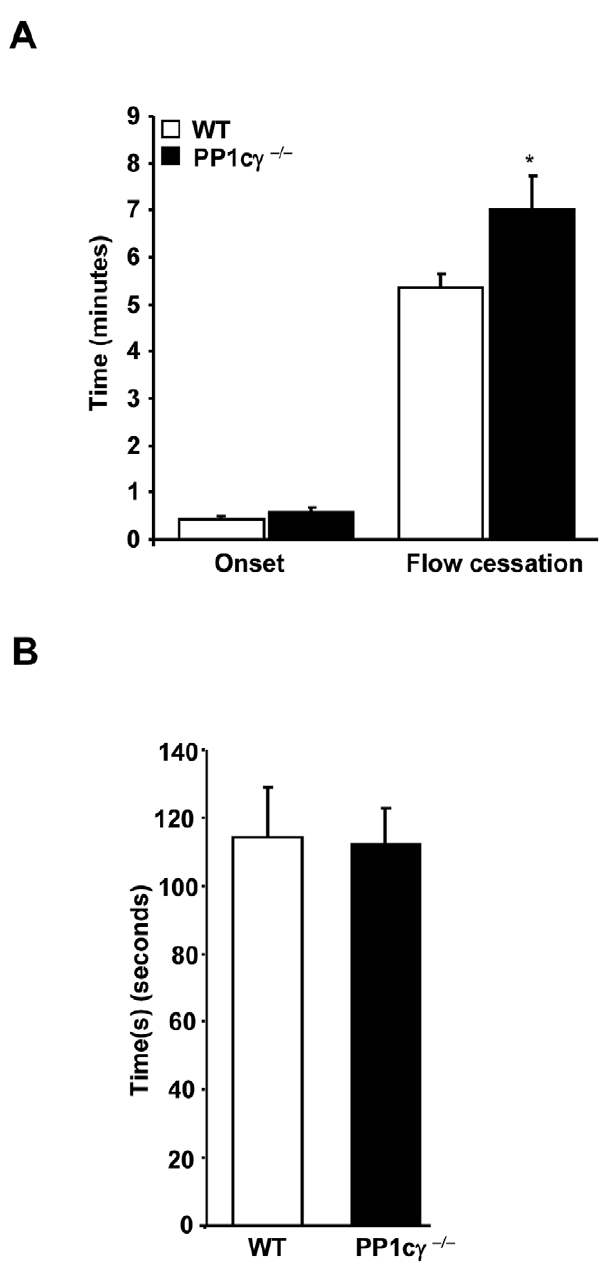
Figure 5. Role of PP1c c in thrombosis and hemostasis injury models. ( A ). Light/dye -induced microvascular thrombosis was studied in the venules of the cremaster muscles of WT and PP1c c 2 / 2 mice by intra vital microscopy. The onset of thrombosis (onset) and the cessation of blood flow following the injury were monitored. Results are expressed as 6 SEM of 13 experiments. Compared to the WT, the delayed time for flow cessation in PP1c c 2 / 2 mice was significant at *p=0.03. ( B ). Tail vein bleeding times from 13 WT and PP1c c 2 / 2 mice are shown. doi:10.1371/journal.pone.0008304.g005 integrin a IIb b 3 activation, soluble fibrinogen binding, platelet